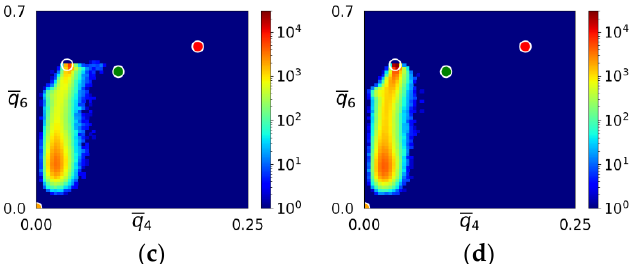
Figure 4. Snapshots of the q 4 – q 6 map during solidification in the sHPFC system for the simulation shown in the upper row of Figure 3. The time elapses from left to right. Maps corresponding to dimensionless times t = ( a ) 800, ( b ) 1400, ( c ) 2000, and ( d ) 5900 are presented. The transparent, green, red, and yellow circles indicate the ideal bcc, hcp, fcc, and icosahedral neighborhoods, respectively. Note the gradual transition from the liquidlike initial amorphous state towards the bcc structure. The “bridge” between the liquidlike and bcc domains indicates transition states corresponding to the MRCO.